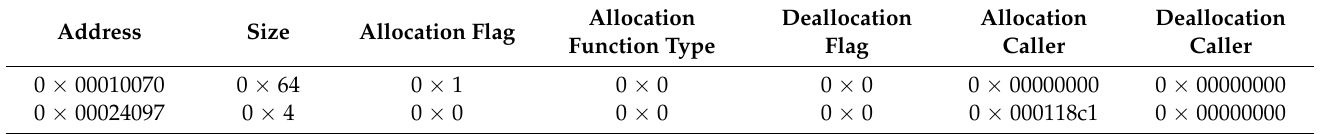
Figure 9. Conceptual diagram of hooking. Table 2. Information tags after performing the malloc() function in Figure 9.